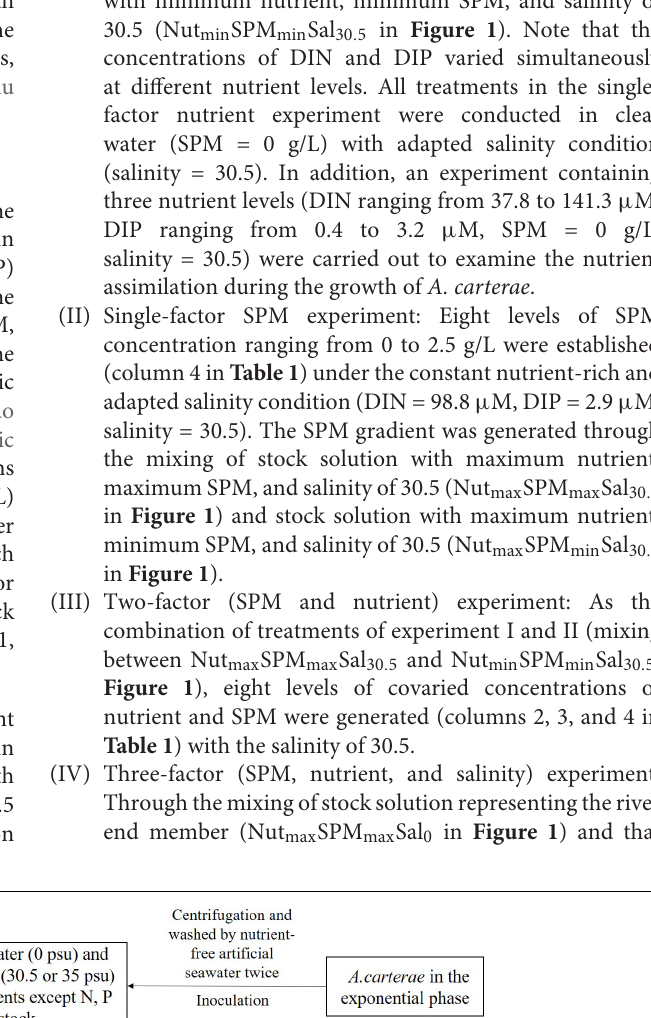
maximum nutrient, minimum SPM, and salinity of 30.5 (Nut max SPM min Sal 30 . 5 in Figure 1 ) and stock solution